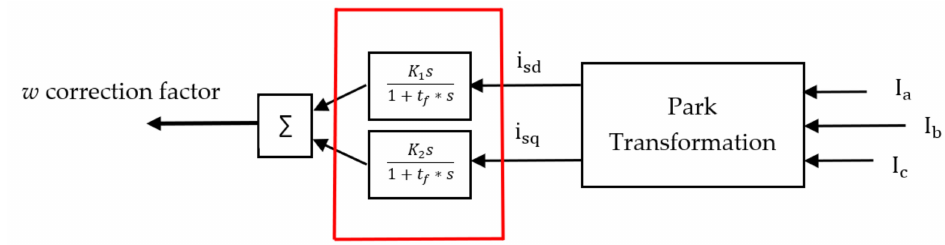
Figure 13. Damping logic implementation block diagram.